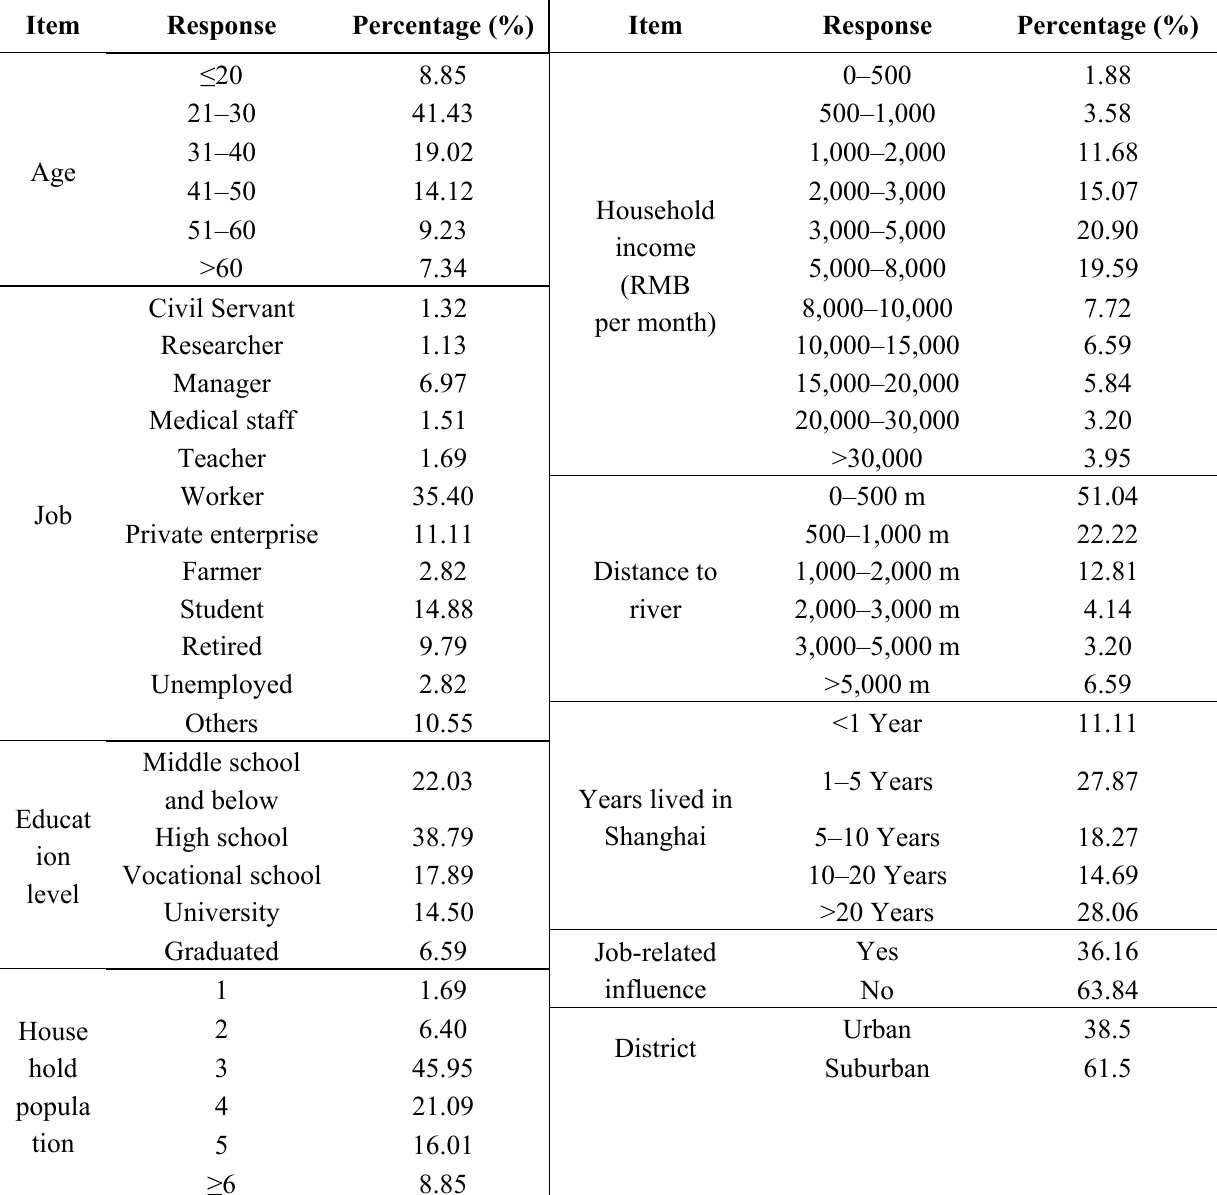
Table 1. Descriptive statistics of socio-economic characteristics of the